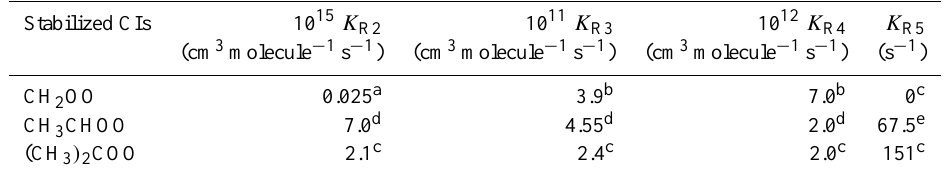
Table 5. Rate constants of sCIs used in the